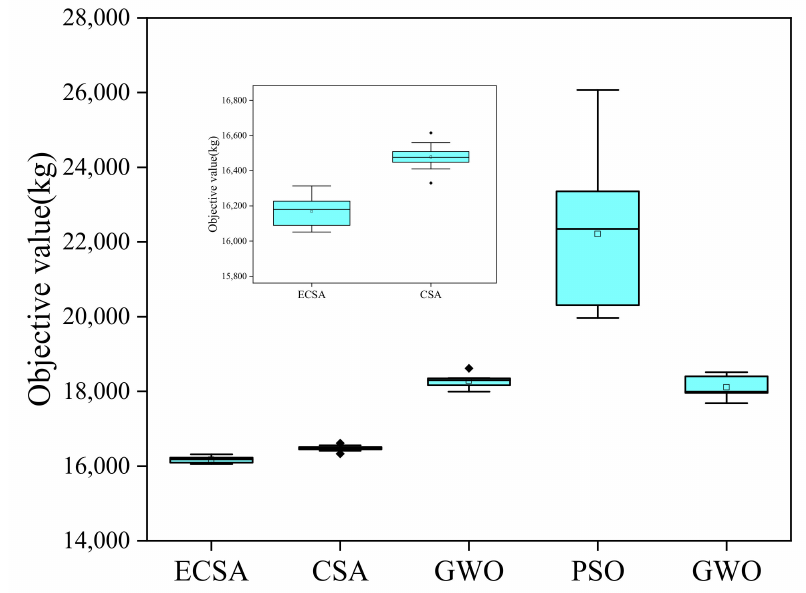
Figure 6. Box diagram of statistical Results.